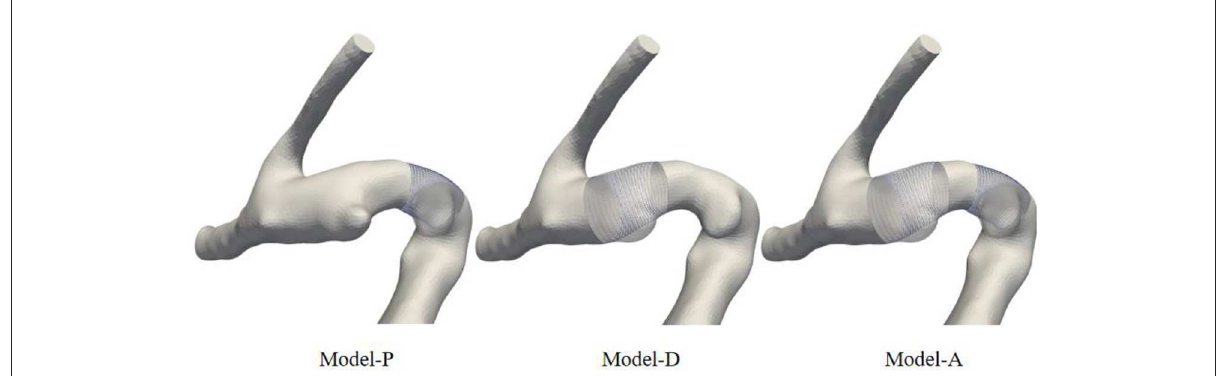
FIGURE1 Schematic diagram of model comparison between pre-aneurysm vasculatures and the original model. The restored vessels were replaced by cylindrical tubes.